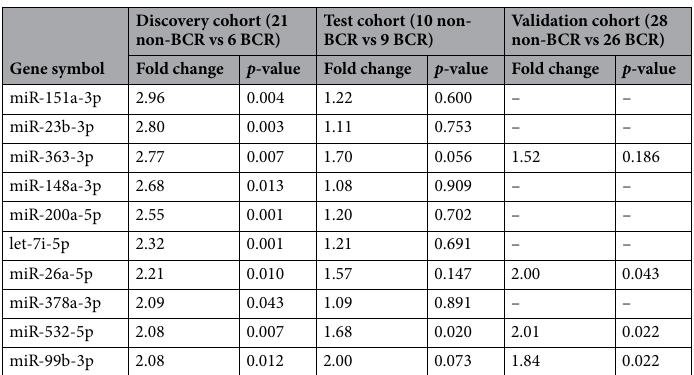
Table 2. Relative expression of candidate miRNAs.